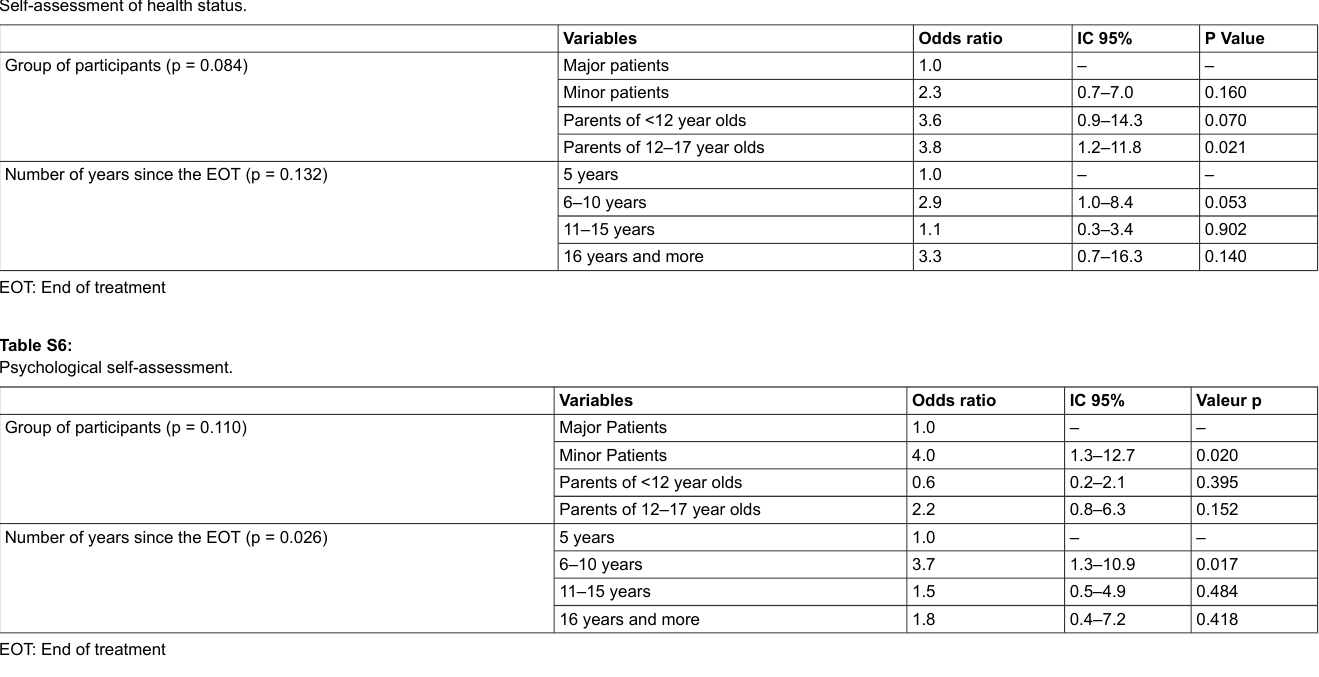
Figure S1: Types of follow-up according to the